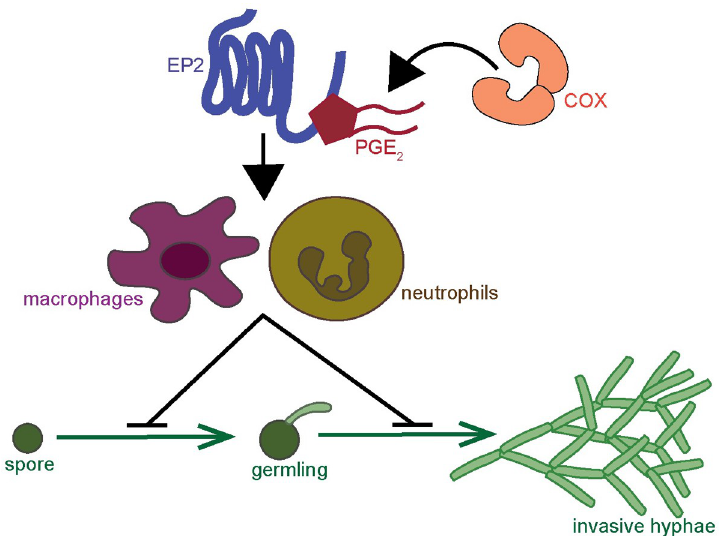
Fig 8. Model of cyclooxygenase signaling in response to A . fumigatus growth. COX enzymes produce prostaglandin signaling molecules, including PGE 2 . PGE 2 can bind to the EP2 receptor to exert pro-inflammatory effects. In zebrafish larvae injected with A . fumigatus , this signaling activates both macrophages and neutrophils to inhibit spore germination and development of invasive hyphal growth.